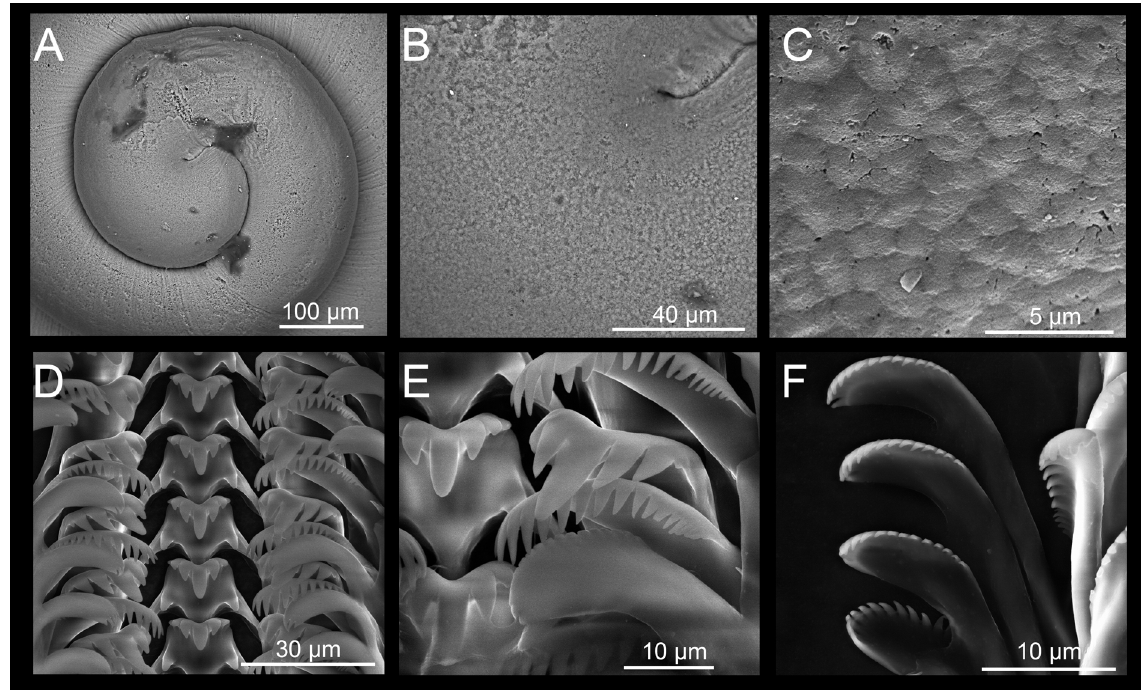
Fig. 18. Protoconch and radula of Mercuria egarensis Miller, García-Guerrero & Ramos sp. nov. from Font de les Canyes, Barcelona, Spain. A . Details of the protoconch. B . Protoconch nucleus. C . Protoconch microsculpture. D . Overview of radular teeth rows. E – F . Detailed view of the inner and outer marginal teeth,